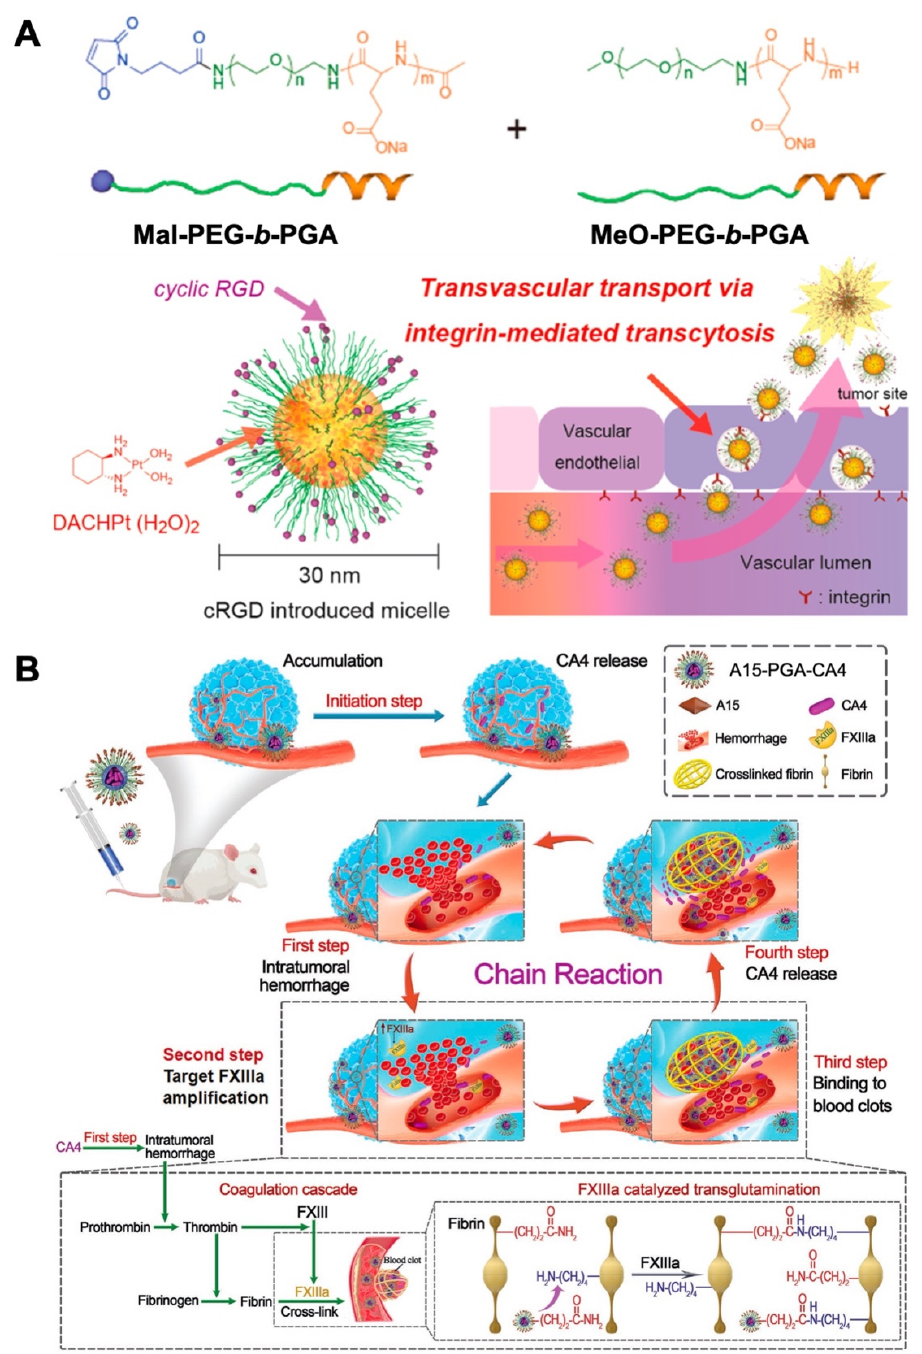
Figure 8. Protein drug-based PGA prodrugs for cancer treatment. ( A ) Preparation of DACHPt-incorporating PEG- b -PGA polymeric micelle with cRGD ligand molecules for the targeted delivery of platinum therapeutic prodrugs to glioblastomas. Reprinted with permission from Ref. [86]. Copyright 2013, American Chemical Society. ( B ) Schematic illustration of the self-amplifying tumor-homing therapeutic nanoplatform working via a chain reaction mechanism. Reprinted with permission from Ref. [87]. Copyright 2020, Wiley-VCH GmbH.